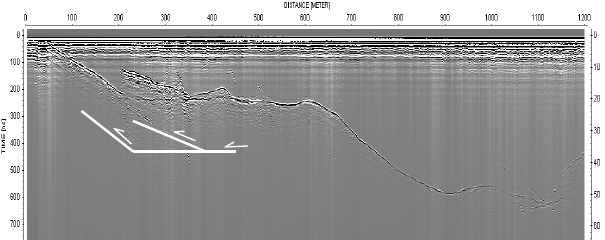
Fig. 9. A thrust fault near the terminus of the glacier. Detail from line running from the terminus up the centre of the glacier. Top and right hand scales are in m, left hand is TWT in ns. Notice the 600m of ice that is less than 30m thick. Gain and dewow are applied. Also noticeable is the completely transparent ice with no evidence of